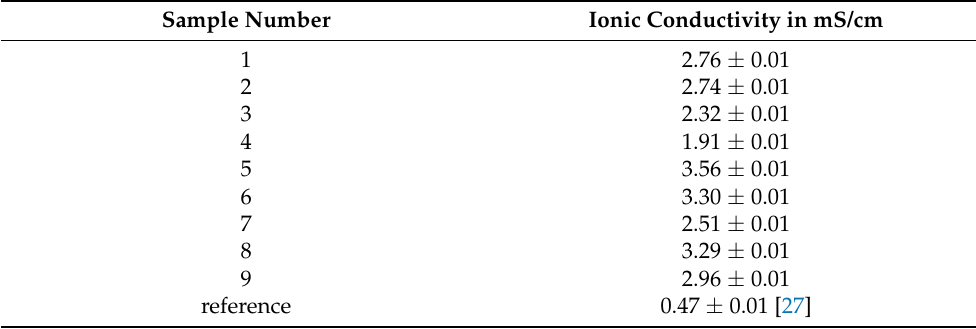
Table 2. Ionic conductivities of the investigated GPEs. The sample number refers to Table 1.